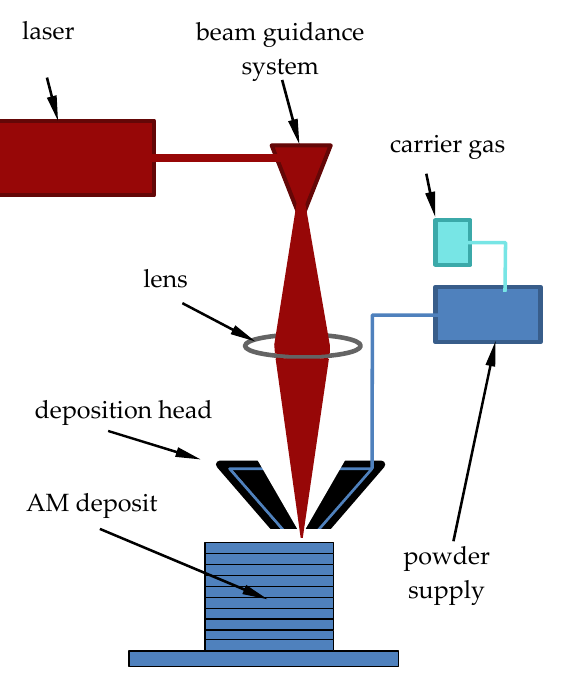
Figure 10. Schematic representation of directed energy deposition (based on the work in [29]).